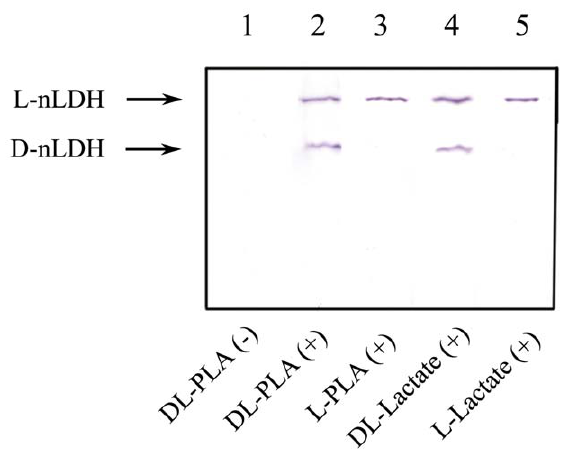
Figure 3. Native polyacrylamide gel electrophoresis staining for PLA and lactate oxidation activities. Symbol ( 2 ) represents solutions without NAD addition and symbol ( + ) represents solutions with 5 mM NAD. DL -PLA was used as substrate for active staining in lane 1 and 2, whereas L -PLA, DL -lactate, and L -lactate were used as substrates in lane 3, 4, and 5, respectively. All substrates were used at a concentra-